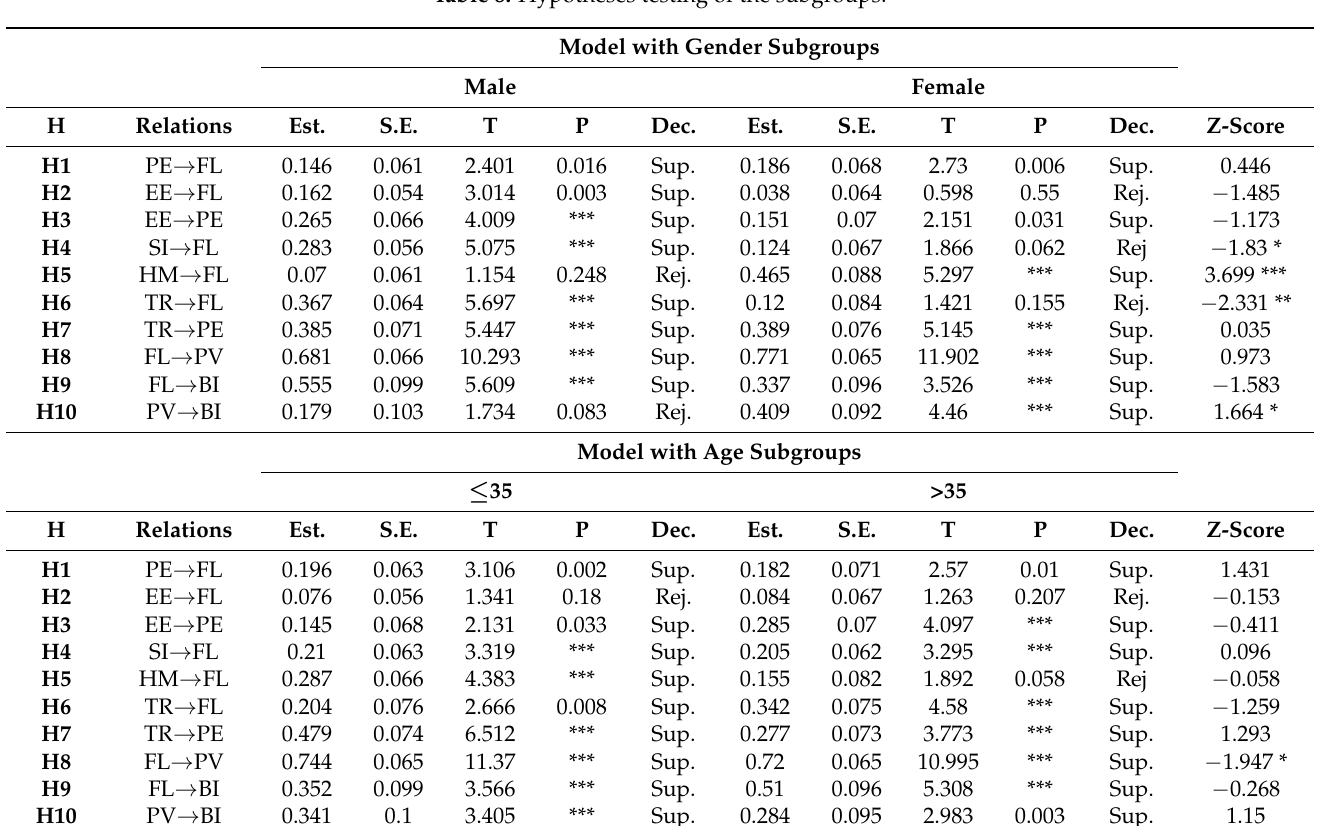
Table 8. Hypotheses testing of the subgroups.